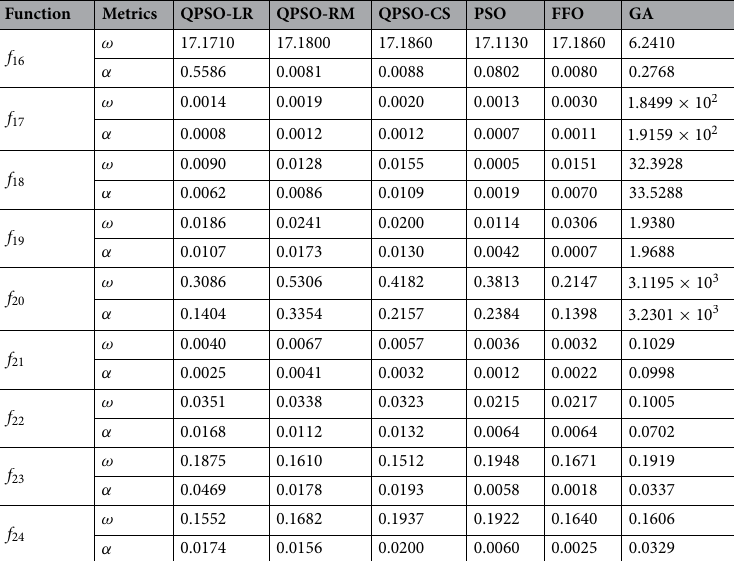
Table 6. Accuracy and precision metrics for fixed-multimodal benchmark functions with N = 30, Tmax = 1000 and Texp = 30.